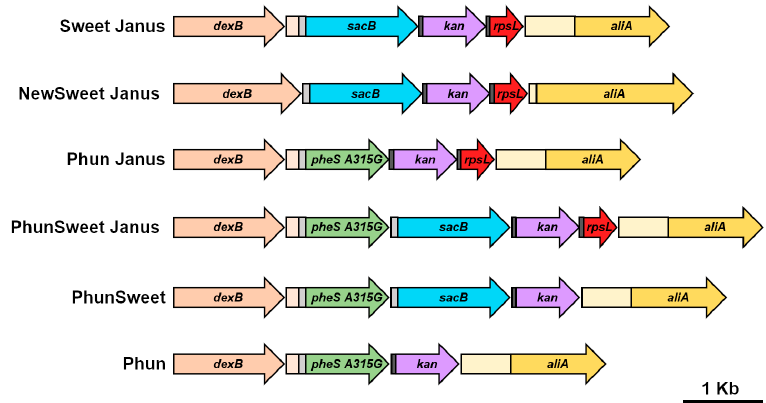
Figure 4. Schematic of novel markerless cassettes generated for allelic replacement of capsule. Each cassette was spliced between the genes flanking the capsule loci, dexB (tan) and aliA (yellow). The cassettes are comprised of genes that confer sucrose sensitivity ( sacB ; blue), kanamycin resistance ( kan , purple), streptomycin sensitivity ( rpsL , red), and chlorinated phenylalanine sensitivity ( pheS A315G, green). The light gray box represents the promoter from Sweet Janus and the dark gray box represents ribosome-binding site. The light-tan box represents the sequence downstream of dexB and the light-yellow box represents the sequence upstream of aliA from D39. The direction of the arrow indicates the gene orientation.